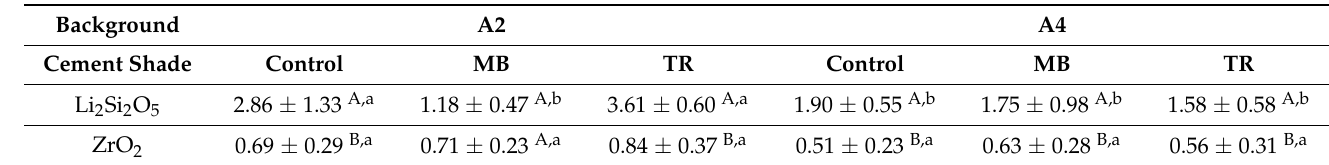
Table 3. Means and standard deviation for TP. Different superscript capital letters indicate significant difference within column ( p < 0.05). Different superscript lower-case letters indicate significant difference within rows ( p <